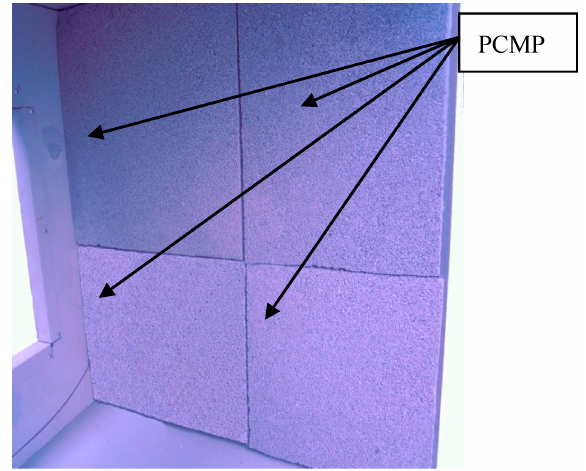
Figure 5. Introduction of tested cell and locations of measuring sensors. ( a ) External view of tested cell; ( b ) Schematic diagram of tested cell.